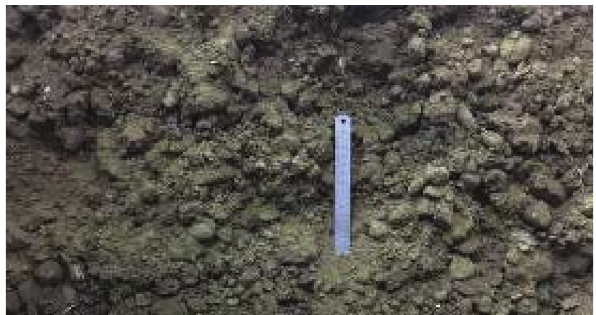
Figure 4: Model soil.